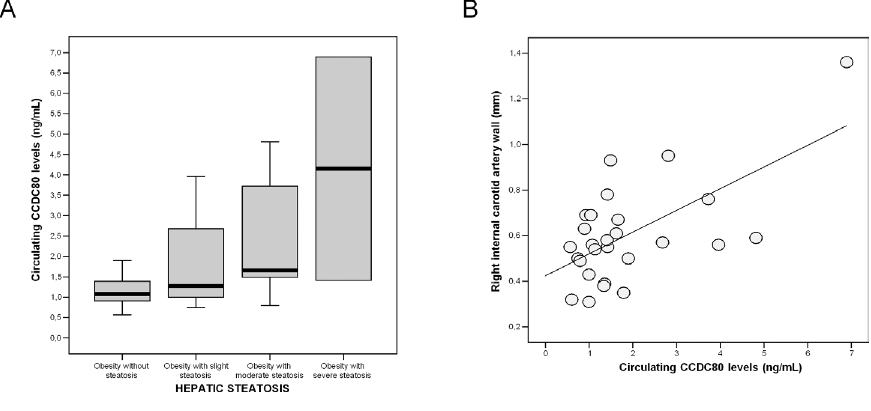
Figure 4. Serum CCDC80 protein levels in a cohort of morbidly obese patients in associa- tion with liver steatosis and carotid atherosclerosis. (A) Box plots showing CCDC80 levels (median value and 25th and 75th percentiles) according to degree of hepatic steatosis in consecutive morbidly obese patients without steatosis (n = 11) compared with slight (n = 10), moderate (n = 5) and severe (n = 2) steatosis. (B) Bivariate correlation analysis between serum CCDC80 protein levels and internal carotid intima-media